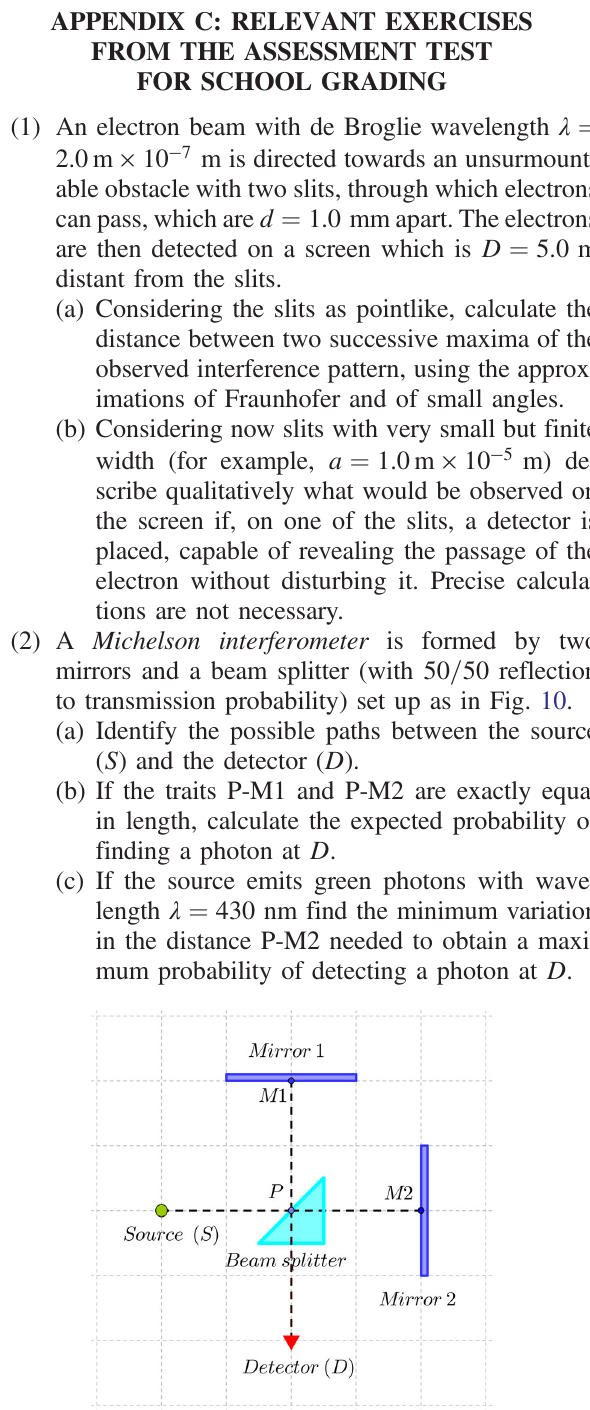
FIG. 10. The Michelson